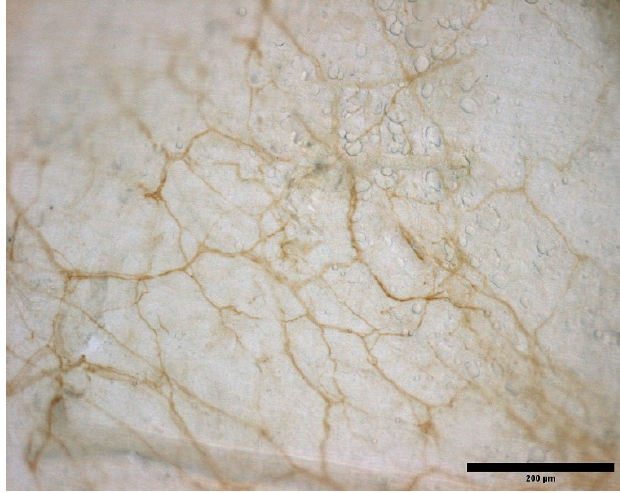
Figure 3. Innervation of a mouse TLF. Sample stained with S100.